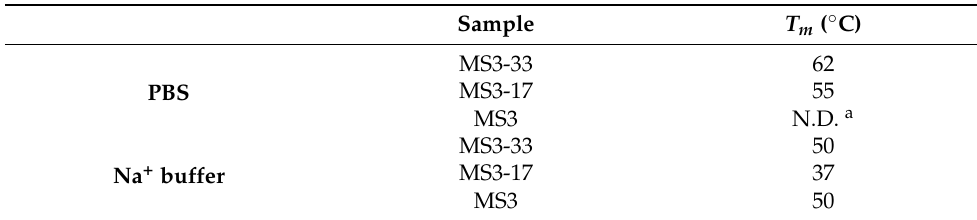
Table 2. Apparent melting temperature values ( T m ) obtained for the unfolding of MS3-33 and MS3-17 analogues in comparison with MS3. The error on T m determination is ± 1.0 ◦ C.